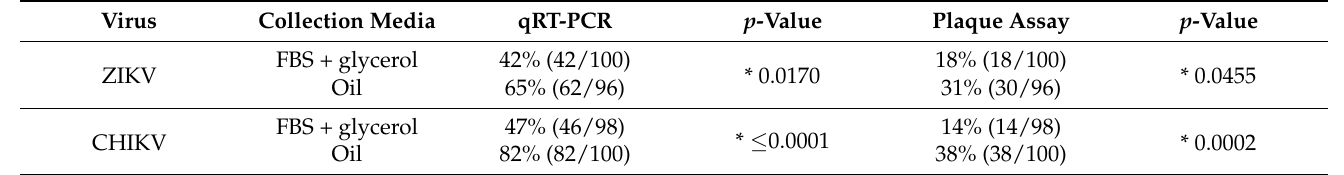
Table 1. Proportions of saliva collections from individual mosquitoes that were ZIKV- or CHIKV-positive using either qRT-PCR or plaque assays when force salivated using oil or FBS-glycerol as the collection media.